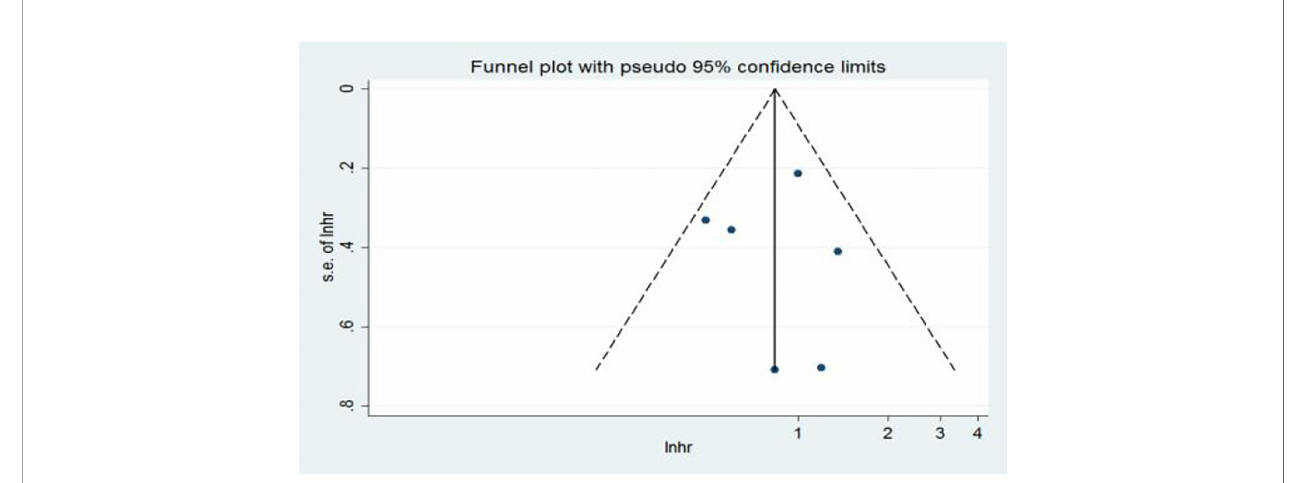
FIGURE 10 | Funnel plots of the relationship between neutrophil – lymphocyte ratio and overall survival in multivariate analysis.